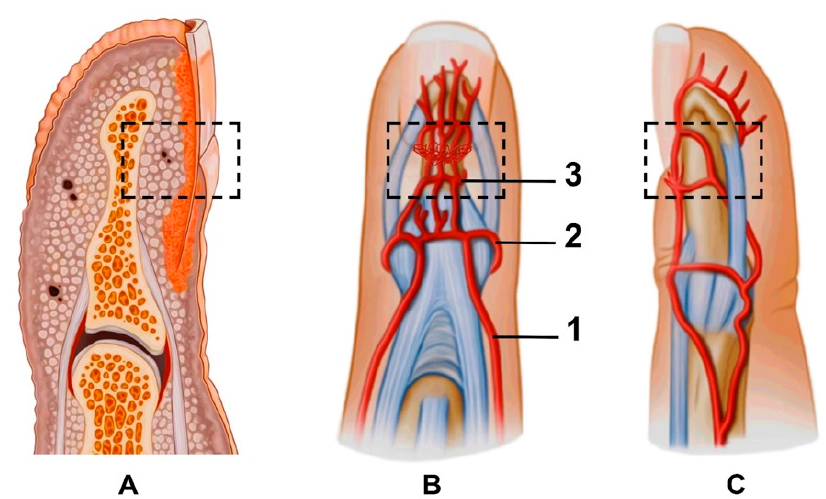
Figure 2. ( A ) Macroanatomy of the fingertip; anterior ( B ) and lateral ( C ) views of the fingertip and nailfold vasculature: 1—proper palmar digital artery, 2—superficial arcade, 3—proximal subungual arcade. Branches supplying the fingertip pulp start from the distal subungual arcade. Dotted boxes mark the anatomical zone of the proximal nailfold vascularity.